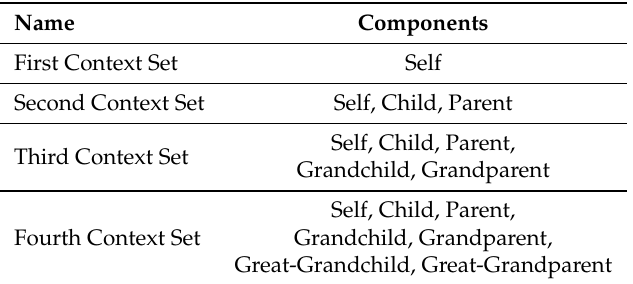
Table 6. Naming of Context Sets.